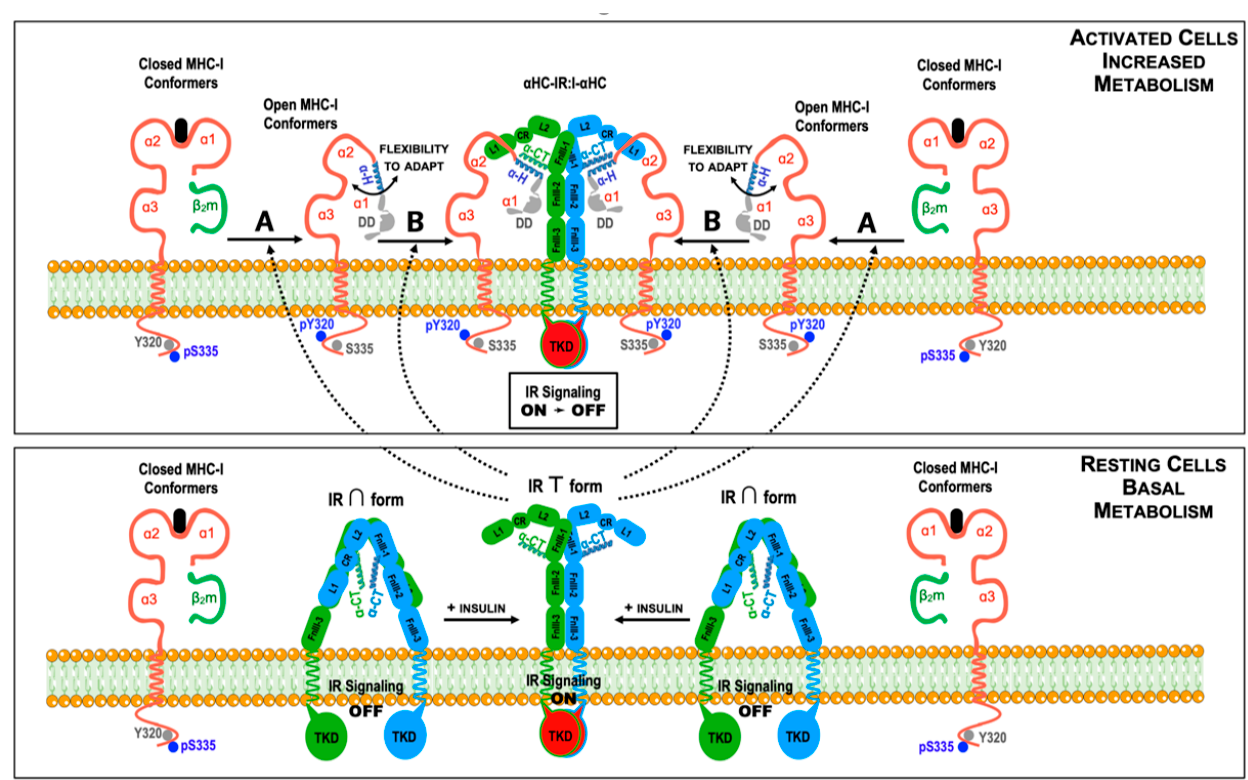
Figure 5. Model for the regulation of insulin signaling by cis-association between cell surface MHC-I molecules and insulin receptors (IR) in insulin-dependent tissues. In resting cells (lower figure), the large majority of MHC-I molecules expressed at the cell surface are closed conformers. Likewise, under resting conditions and low circulating insulin levels, the IR is in its inactive ∩ conformation (signaling off), with the α -C-terminal domains ( α -CT) of the IR α chains hidden [120,121]. An increase in the metabolic activity of the cells and the presence of insulin in the external milieu will result in binding of insulin to the IR, inducing a shift towards the active T conformation (signaling on) and the exposure of the α -CT domains [116–121]. Under these conditions, the T conformation of the IR with the bound insulin may follow two paths (upper figure). A, to induce the dissociation of β 2m and the peptide from nearby closed MHC-I conformers, generating open conformers. B, to directly associate with pre-existing open conformers. In either case, the cis-association may occur between the α -CT domains of the α extracellular chains of the IR and the α -helix ( α -H) of the α 1 domains, leading to the formation of a complex constituted by one IR:I complex and two α HCs ( α HC-IR:I- α HC). Alternatively, the α -helix ( α -H) of the MHC-I α 1 domains may also interact with N-terminal sequences of the transmembrane β chains of the IR (not shown). Phosphorylated amino acid residues in the cytoplasmic domain of MHC-I molecules are indicated, as in Figure 1. Whether the Tyrosine Kinase Domains (TKD) of the β chains of the IR are involved in the phosphorylation of Tyr320 is not known, but is a likely possibility.